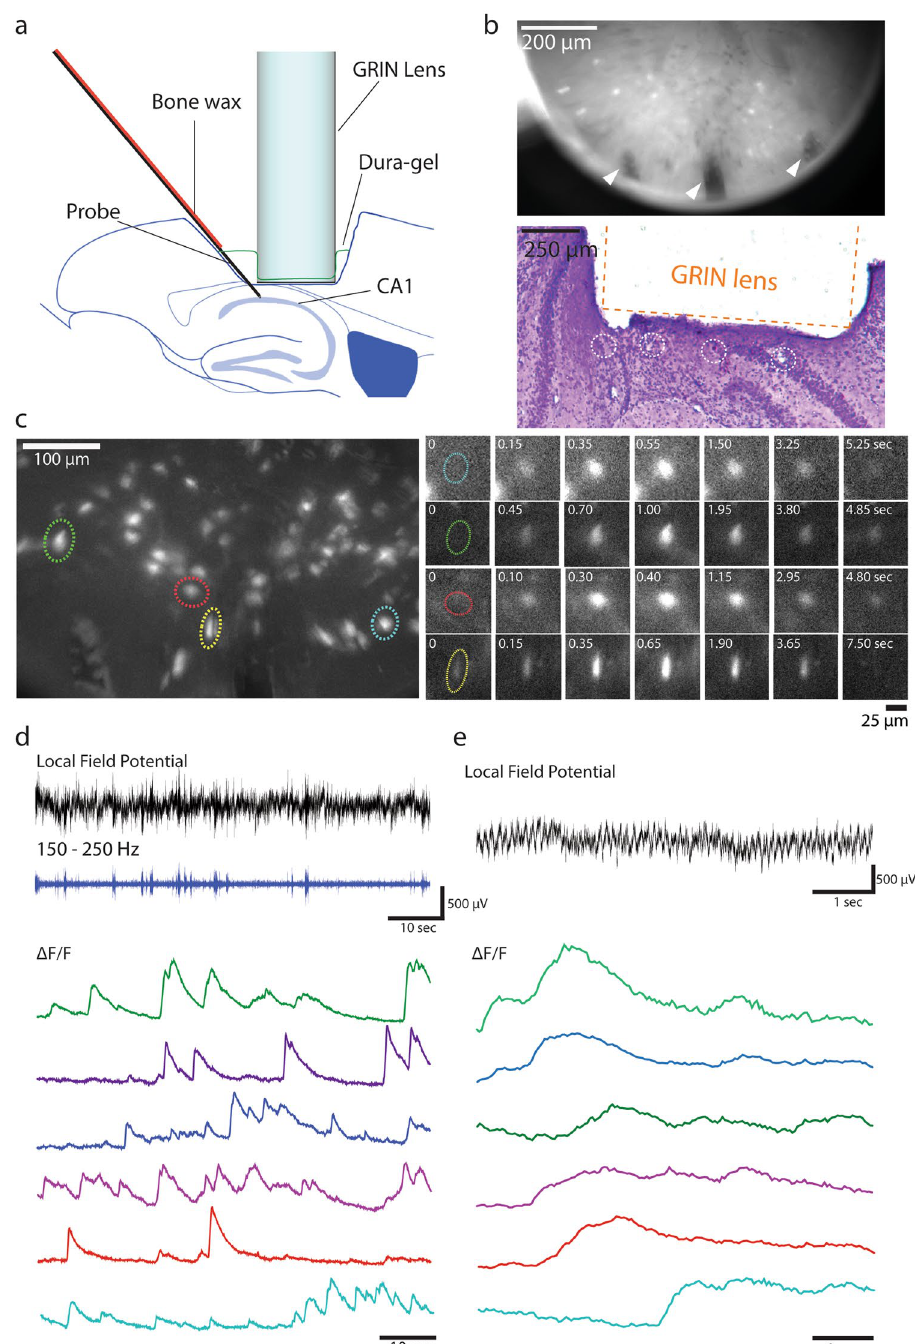
Figure 6. Bimodal recording of neuronal calcium signalling and LFP in CA1 using a GRIN lens and a silicon probe. ( a ) Position of a GRIN lens and a silicon probe for bimodal recordings in the CA1 area. ( b ) Confirmation of the placement of the GRIN lens and the silicon probe. Top: A frame of fluorescence image showing the existence of silicon probe shanks under the GRIN lens (Arrowheads). Bottom: An image of a cresyl violet- stained brain section showing the location of the four shanks of the silicon probe (white dotted circles). Orange dashed line indicates the estimated position of the GRIN lens. ( c ) Left: A ΔF/F image showing Individual neurons expressing GCaMP6s. Right: Example frames indicating changes in fluorescence during a calcium event for each of four neurons. Colors correspond to colors of dashed circles in the left image. ( d ) An example of temporally matched traces of LFP and neuronal calcium signals. Raw and band pass-filtered traces (150– 250 Hz) are presented in black and blue lines, respectively. The band pass-filtered traces show multiple episodes of sharp wave-associated ripples. Calcium signals from different neurons are presented in different colours. ( e ) Another example temporally matched traces while the mouse runs. We observed clear theta oscillations (8–12 Hz). Data in this figure were recorded 32 days after